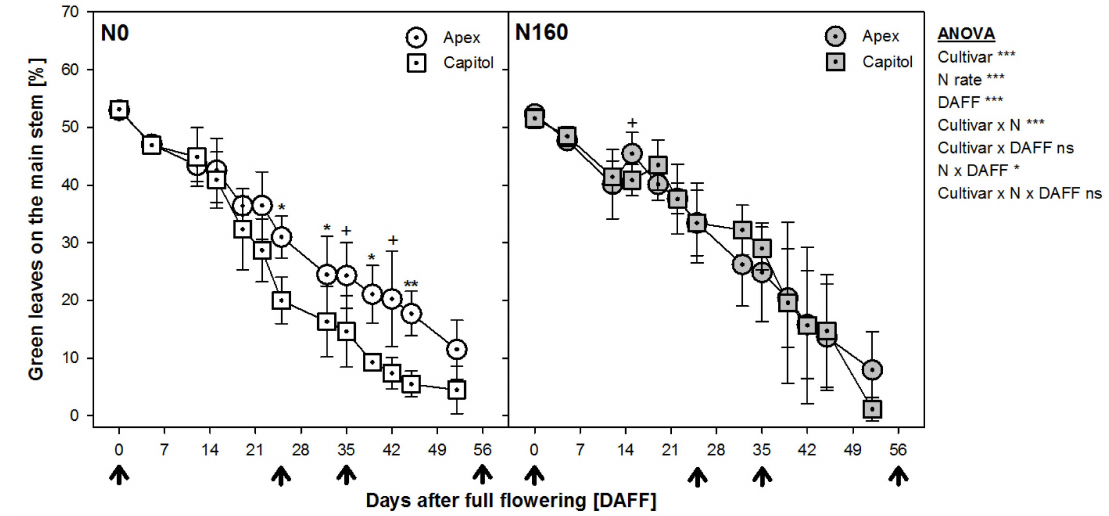
Figure 1. Remaining green leaves on the main stem of the winter oilseed-rape line-cultivars Apex and Capitol from full flowering until near maturity as affected by the N fertilization rate (N0 and N160). The arrows indicate the developmental stages BBCH65, BBCH69, BBCH79, and BBCH89, respectively. ANOVA: *** and * indicate significant differences at p < 0.05 and p < 0.001, respectively. ns = non-significant. At individual DAFF: +, * , and ** indicate significant differences between the cultivars within the N fertilization rates at p < 0.10, p < 0.05, and p < 0.01, respectively. The error bars (visible only when greater than the symbols) represent the standard deviations of the means ( n =